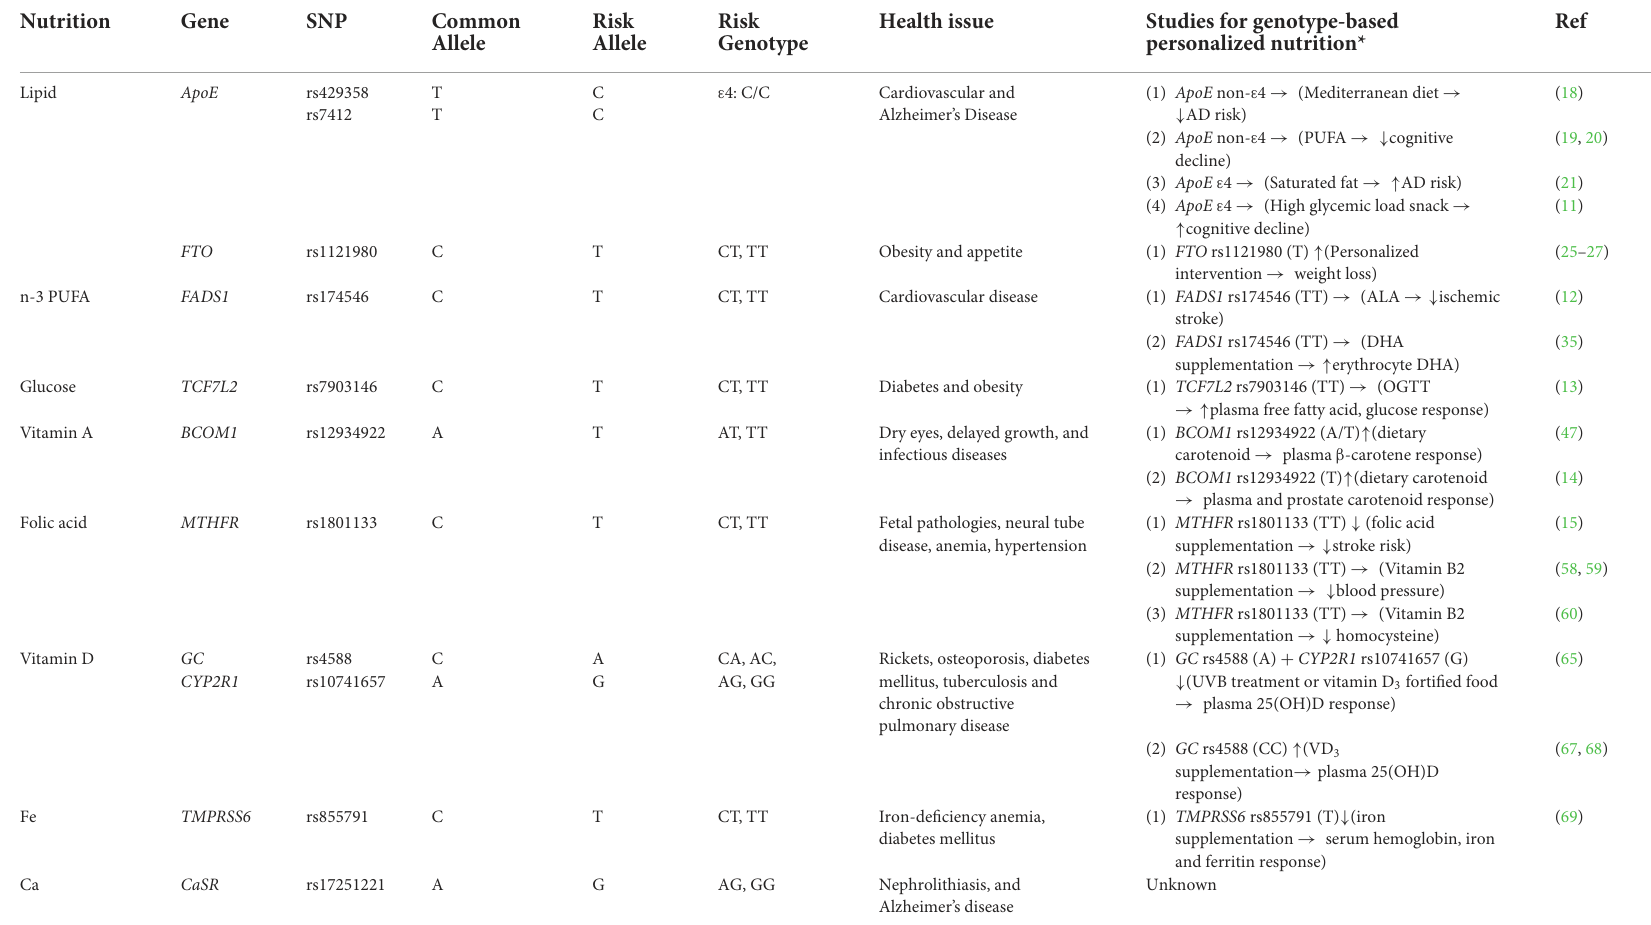
TABLE 1 Summary of nutrigenetic evidence for the role of nutritional supplementation in personalized